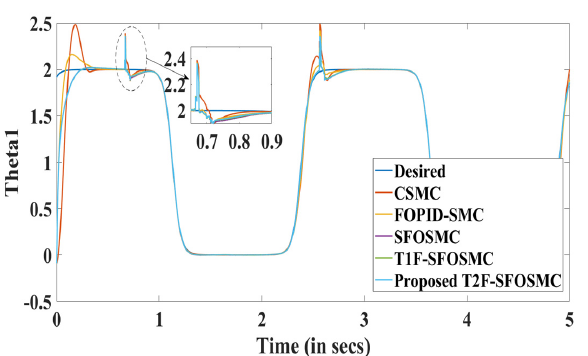
Figure 12. Trajectory tracking of the 3DOF surgical manipulator for Joint1 with disturbances. Electronics 2023 , 12 , x FOR PEER REVIEW